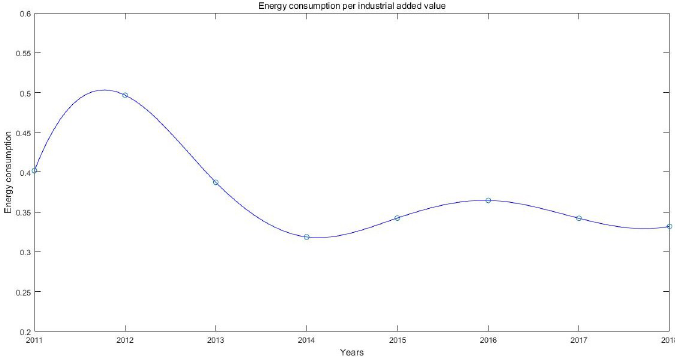
Fig 1. Change of energy consumption per unit industrial added value in the